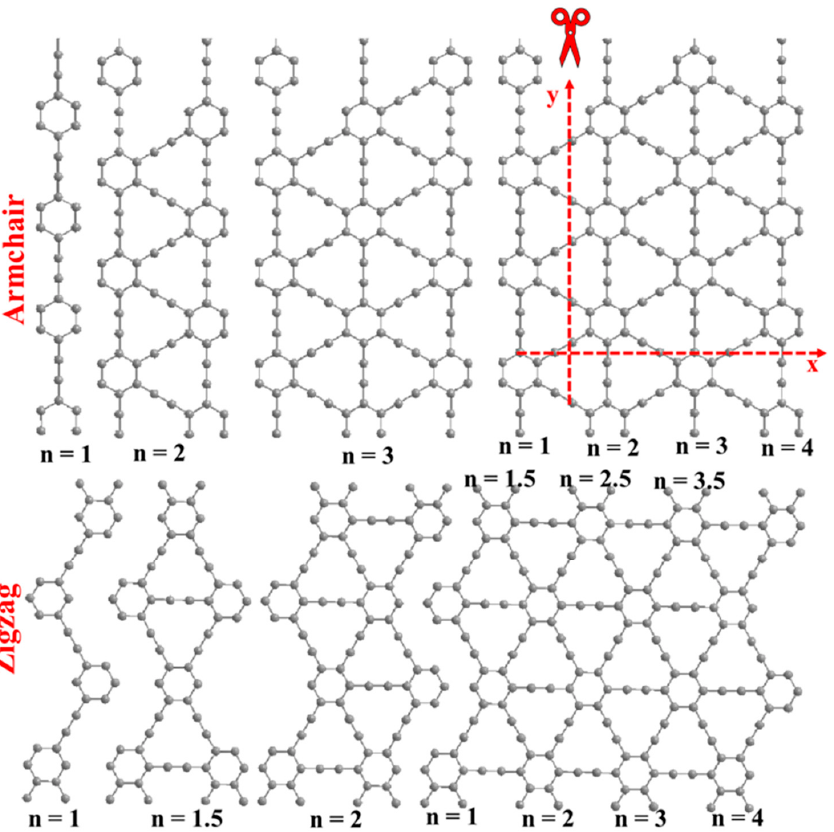
Figure 15. Armchair and zig-zag GY nanoribbons were achieved through the scissoring of the layer along the x and y directions. Redrawn [140].